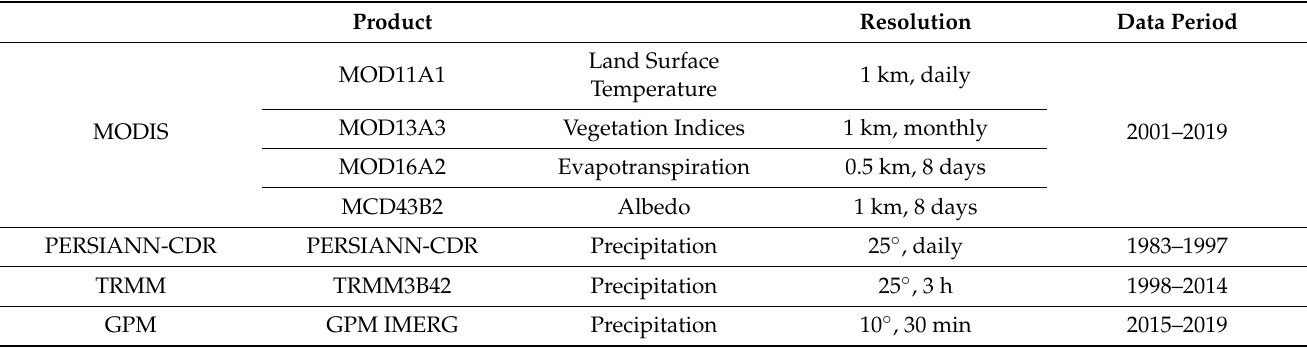
Table 1. Remote sensing (RS) data used in this